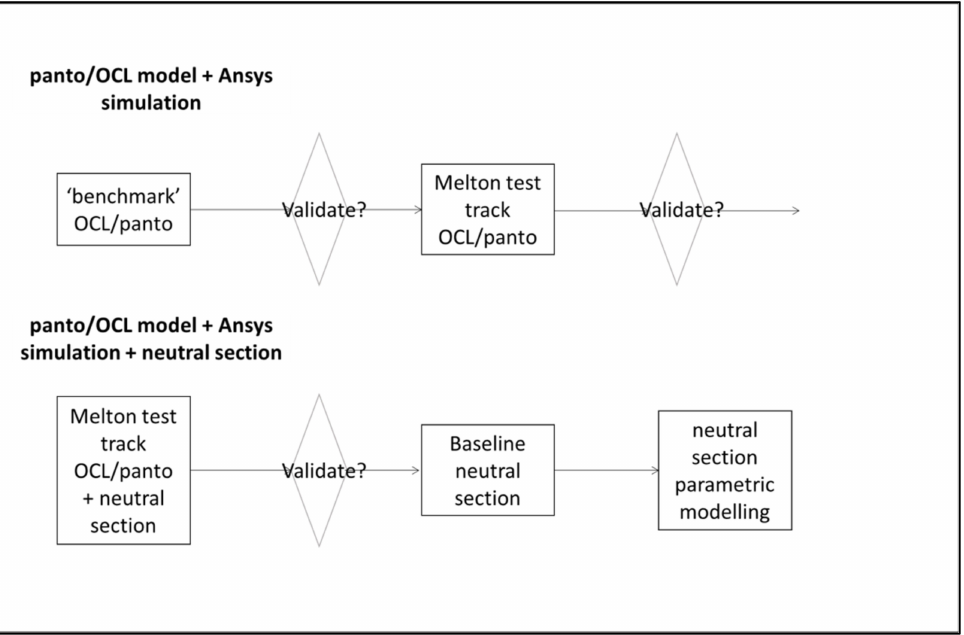
Figure 6. Flow chart of the analysis and validation work